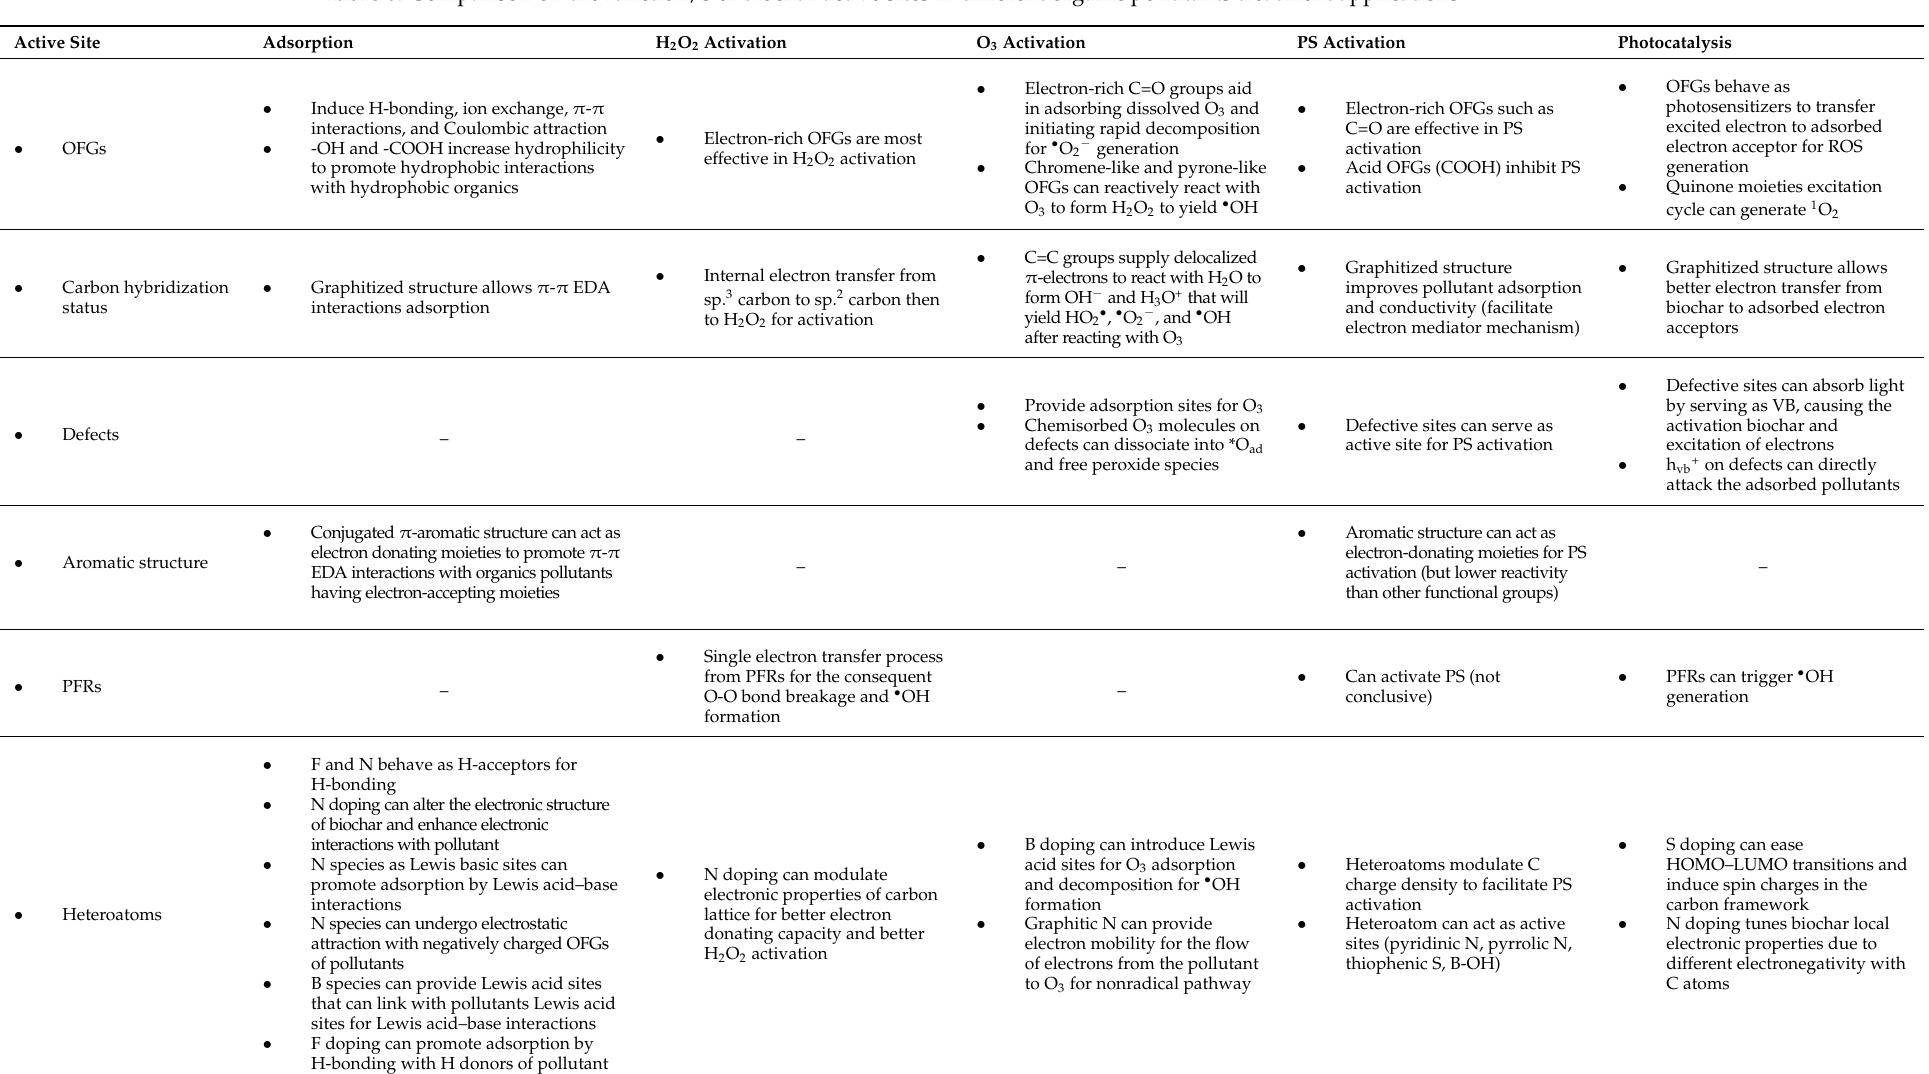
Table 6. Comparison on the function/s of biochar active sites in different organic pollutants treatment